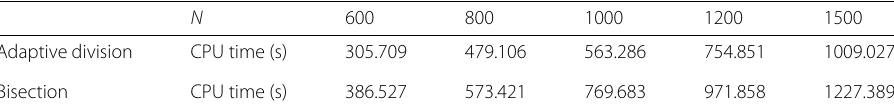
Figure 1 Average computational time in seconds when n = 3, N = 50 and ε = 0.05